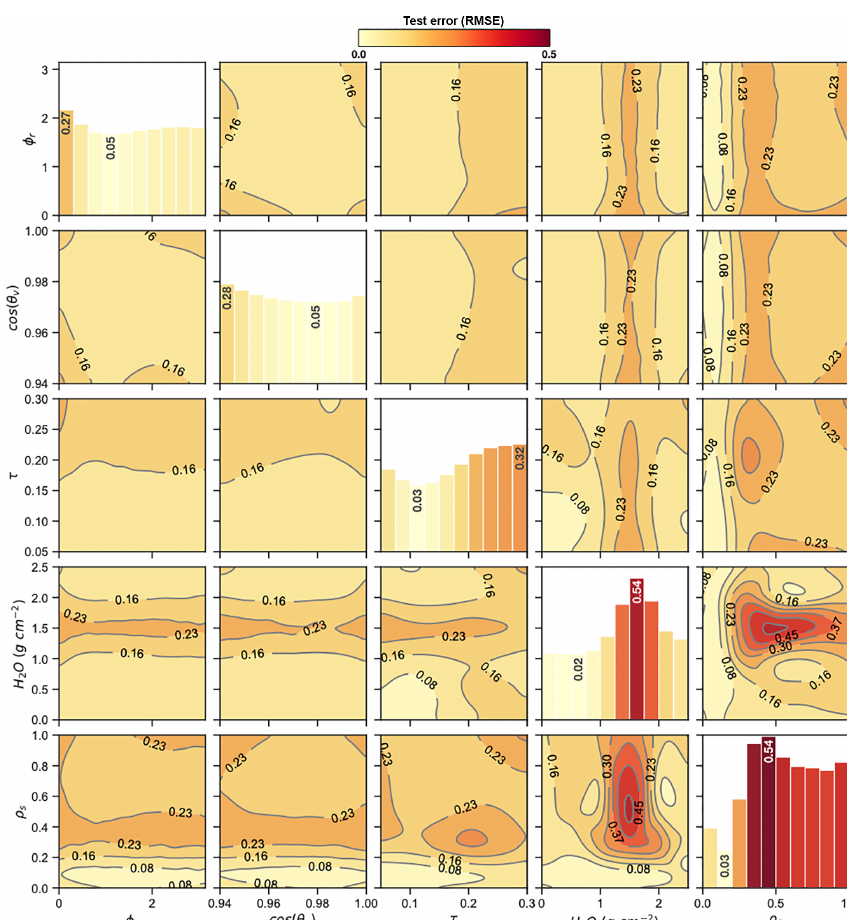
Figure 5. Pairwise contour plots showing the ρ obs test prediction error (RMSE) surfaces with respect to the state parameter values specified in Table 1. Contour labels on the off-diagonal subplots give the error levels associated with each contour. Diagonal subplots show the average RMSE in 10 uniformly spaced bins spanning the ( x axis) range of each parameter. Vertical labels on the diagonal subplots indicate the minimum and maximum error values for each parameter and their corresponding bins.